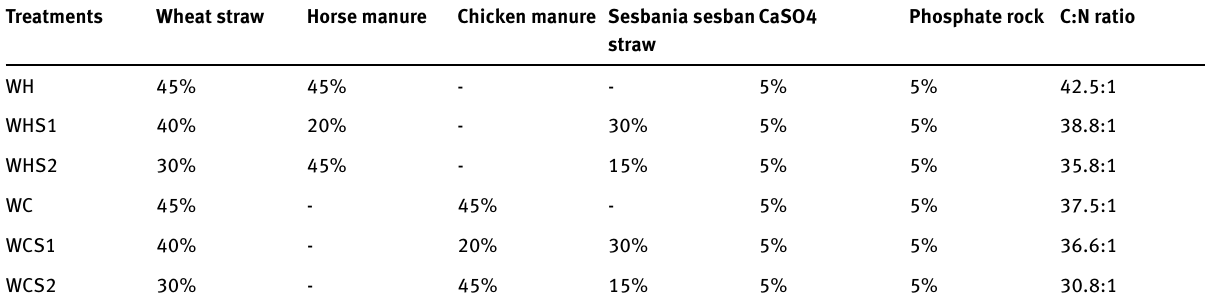
Table 1: Compositions of composts and their carbon:nitrogen (C:N) ratio (By dry weight) Treatments Wheat straw